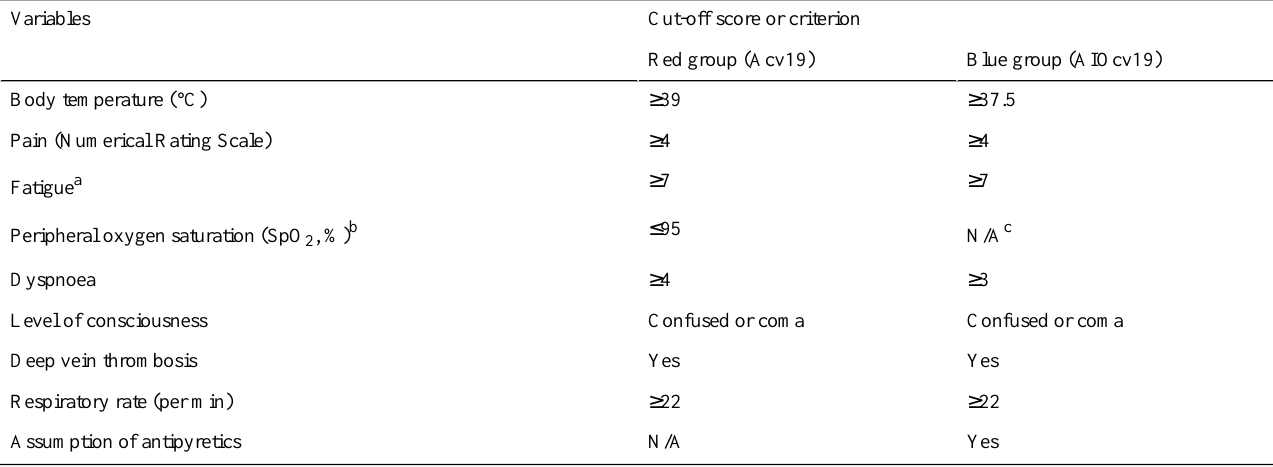
Table 1. Participants’grouping, variables, and cut-offs adopted for the TreCovid19 app.